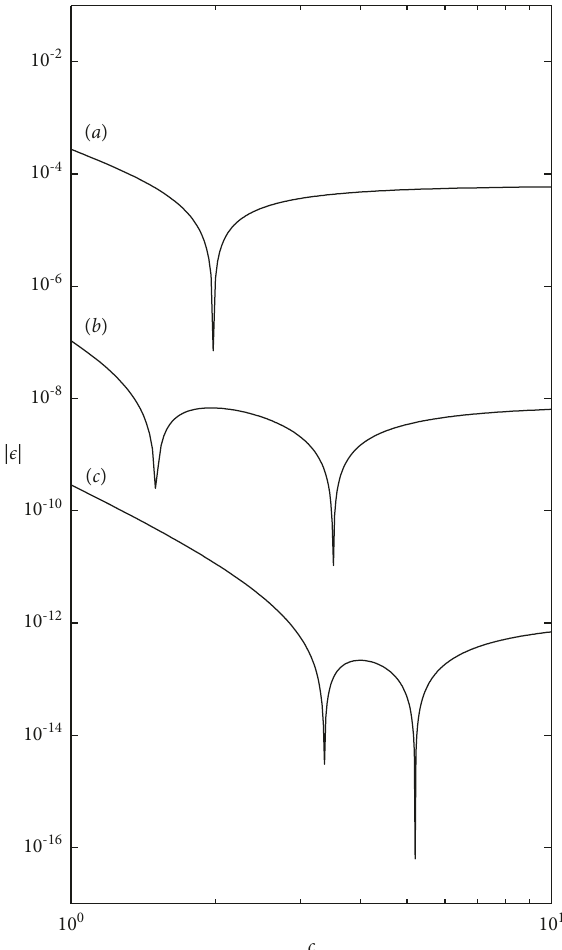
Figure 2: Absolute value of local truncation error ϵ RBF-FD approximation of u ″ as function of c using structured stencils with ( a ) n � 3, ( b ) n � 5, and ( c ) n � 7 ( u ( x ) � exp (− x 2 ) , h � 0 . 01, and x �